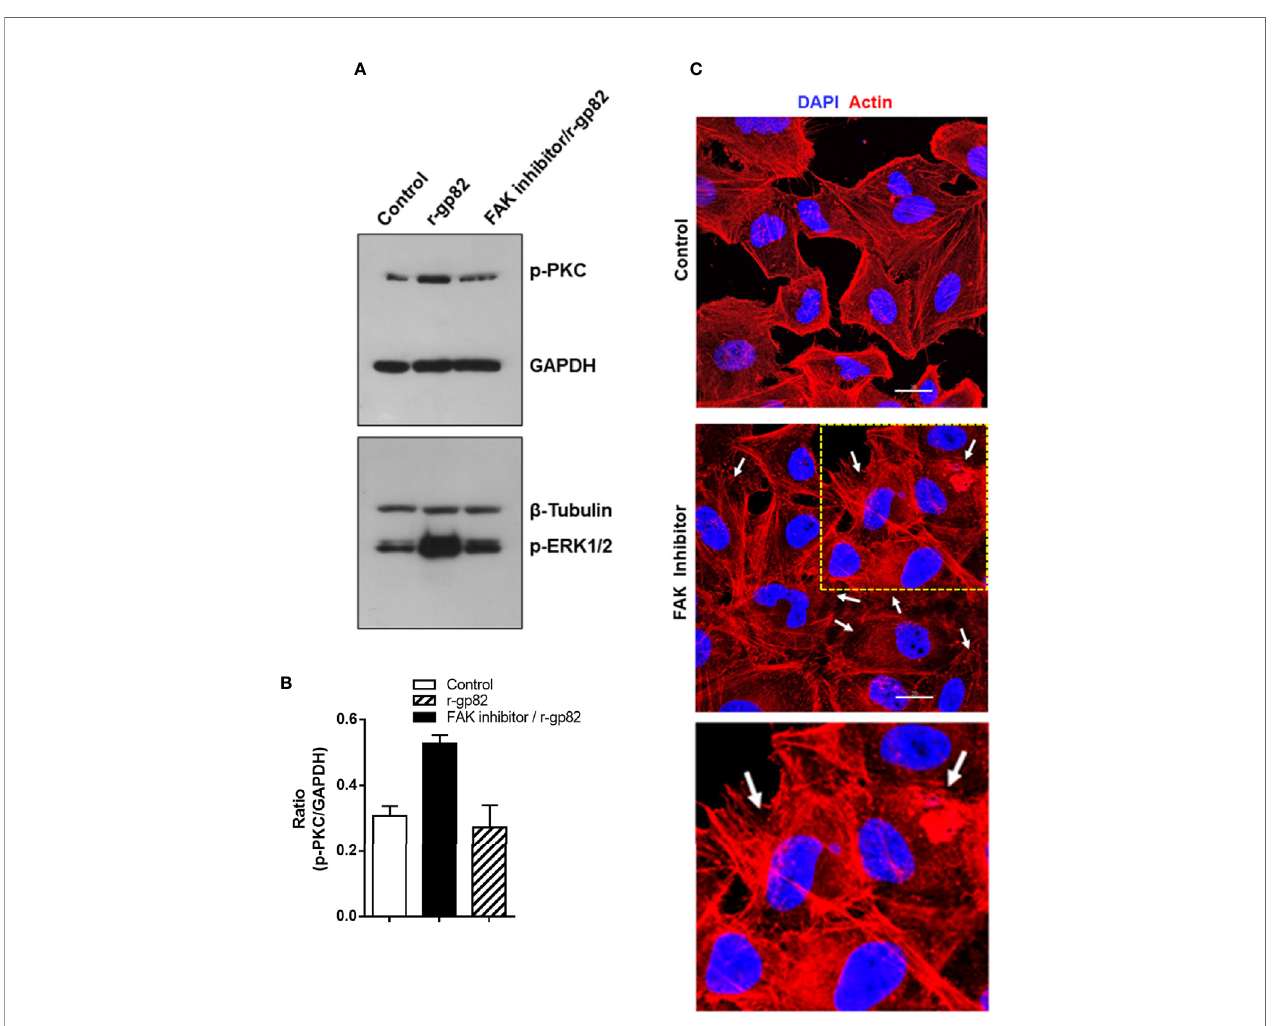
FIGURE 6 | Inhibition of gp82-induced activation of host cell PKC and ERK1/2 by FAK inhibitor. (A) HeLa cells, untreated or pretreated with FAK inhibitor, were incubated for 30 min in absence or in the presence of r-gp82, and analyzed by Western blotting for detection of phosphorylated PKC and ERK1/2. Note that treatment with FAK inhibitor counteracted the gp82-induced activation of PKC and ERK1/2. (B) Shown is the ratio of p-PKC/GAPDH. Values are the means ± SD of duplicate assays. (C) HeLa cells, untreated or treated with FAK inhibitor, were processed for visualization of actin cytoskeleton (red) and nucleus (blue). Scale bar = 20 µm. Note the extensively disorganized actin cytoskeleton in cells treated with FAK inhibitor (white arrows). To facilitate visualization, a magni fi ed image from the framed area (square) is also